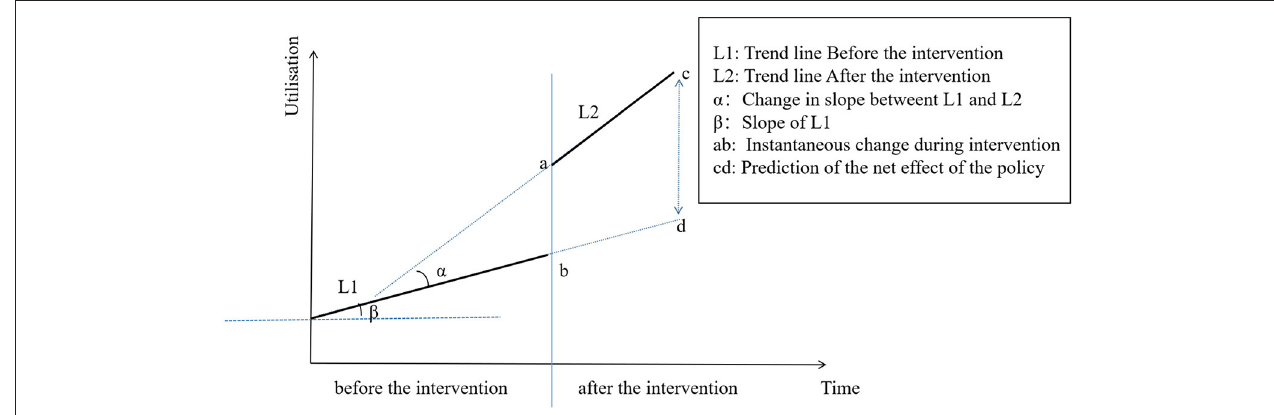
FIGURE 1 | Graphic illustration of the interrupted time-series model and measurement of the policy effect based on trend lines for data points before and after policy implementation.